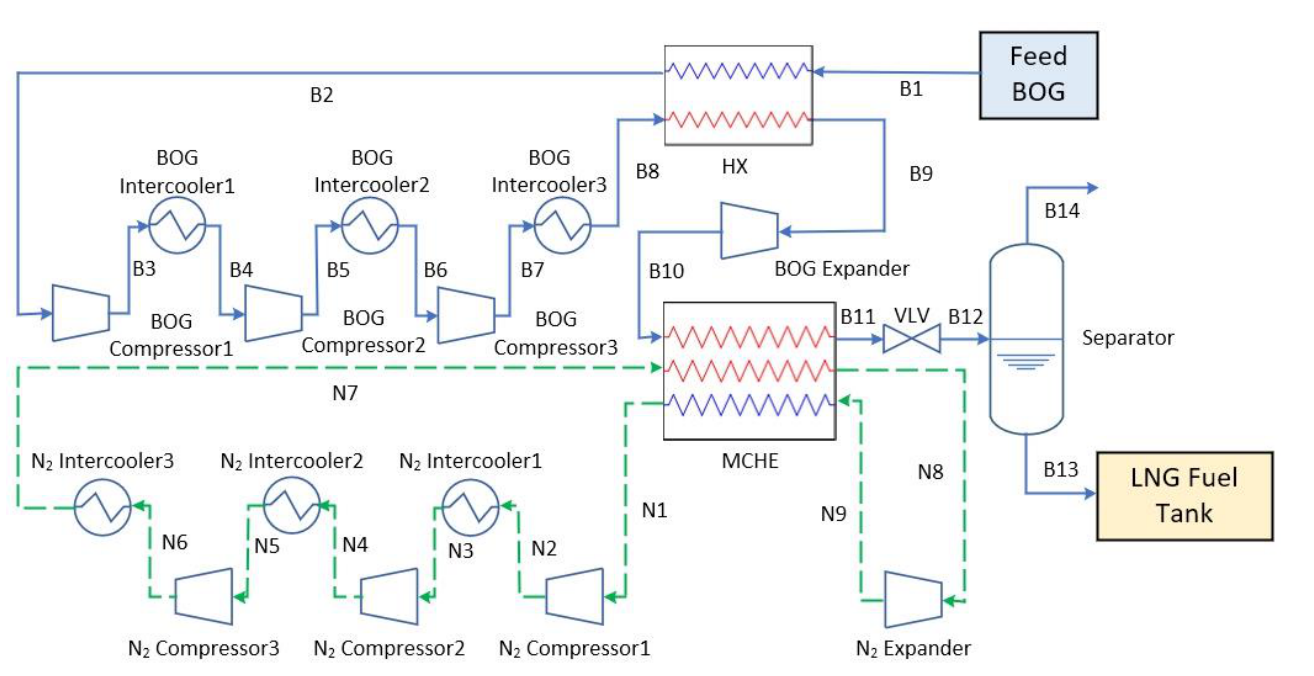
Figure 2. Schematic of the BOG re-liquefaction system presented in Shen et al. [25].